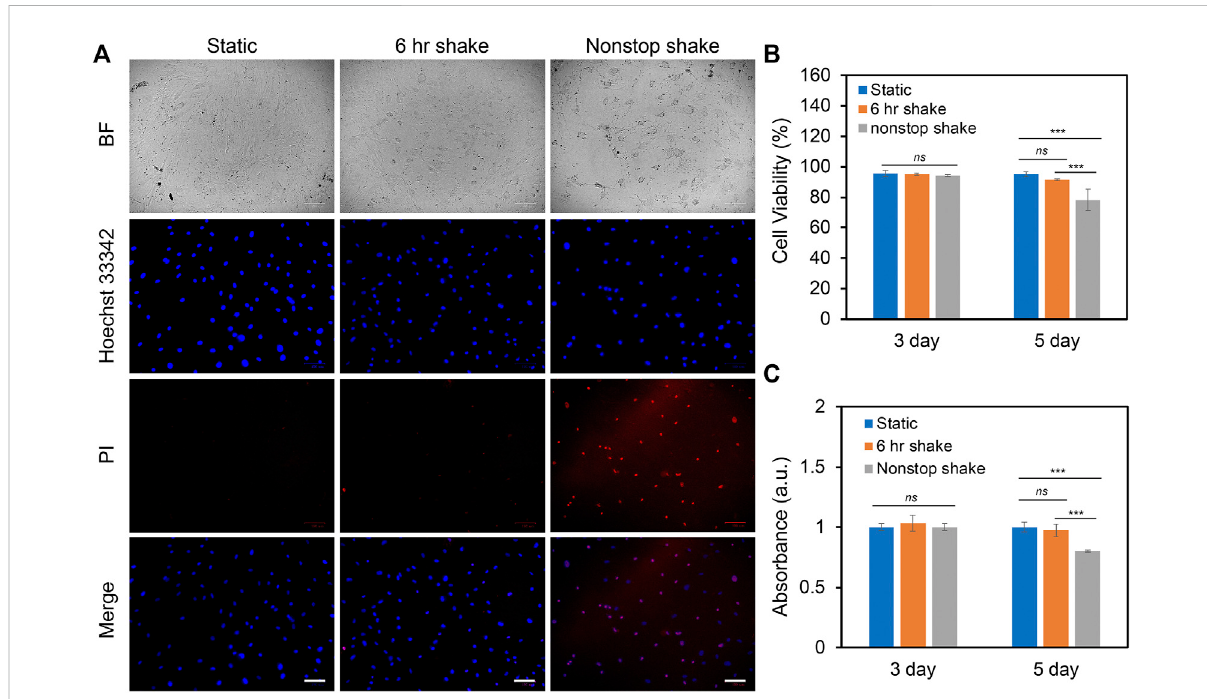
FIGURE 2 Effects of shearstress on cell viability and proliferation. (A) Representative bright fi eldand fl uorescence imagesofhMSCsafter 5 days ofculture with the speed of 20 RPM under static, 6 h shake, and nonstop shake conditions, respectively. Static: cells were placed in a CO 2 incubator without shear;6 hshake:cellswereplacedontheorbitalshakerfor6 hperday;nonstopshake:cellswereplacedontheorbitalshakerwithoutstop.Samples werestainedwithpropidiumiodide(PI,red),andhoechst33342(blue),respectively.Scalebar:100 μ m. (B) ComparisonofcellviabilityofhMSCs after 3 and 5 days of culture under three different conditions, respectively. Cell viability was calculated as: # of live cells per fi eld/total # of cells per fi eld x 100%. Data represents over 500 cells in each group and expressed as mean± s.e.m. ( n = 4, ns , not signi fi cant, ***, p < 0.001, **, p < 0.01).